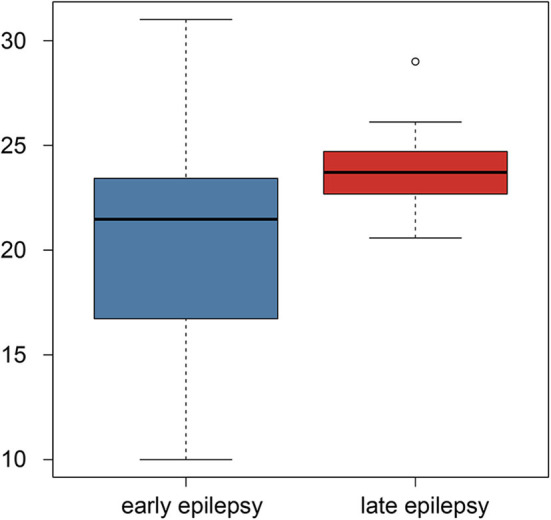
Boxplot of the selected feature comparison between the early-onset and late-onset epilepsy patients.